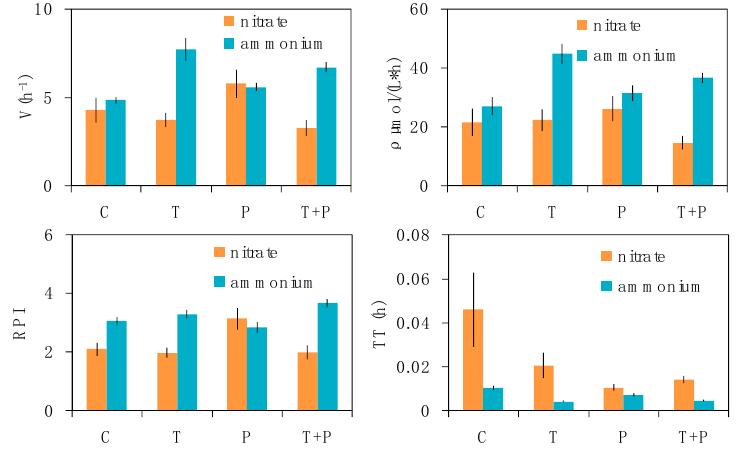
Figure 3. Relative nitrogen uptake rate (V), absolute uptake rate ( ρ ), relative preference index (RPI), and turnover time (TT) for phytoplankton in the four treatments ( n = 6). For abbreviations used, see Figure 1. Error bars indicate ± standard error (SE).